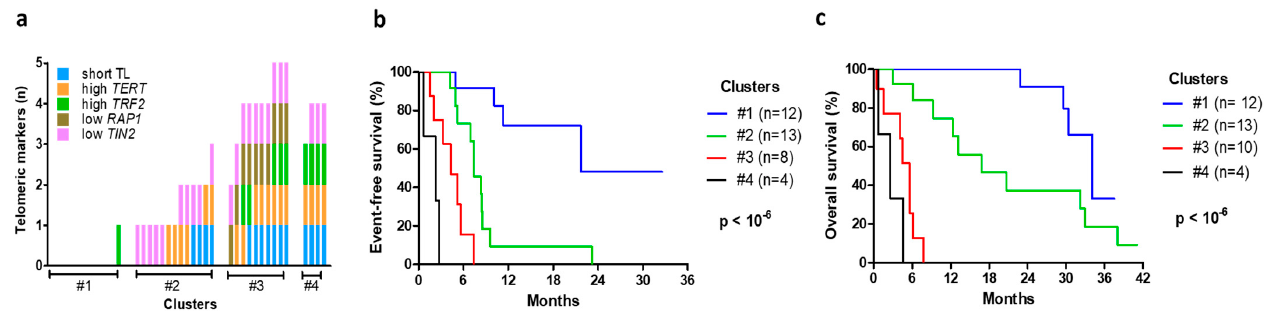
Figure 3. Telomeric markers combined together ( a ), statistically correlated with event-free ( b ) and overall survival ( c ).